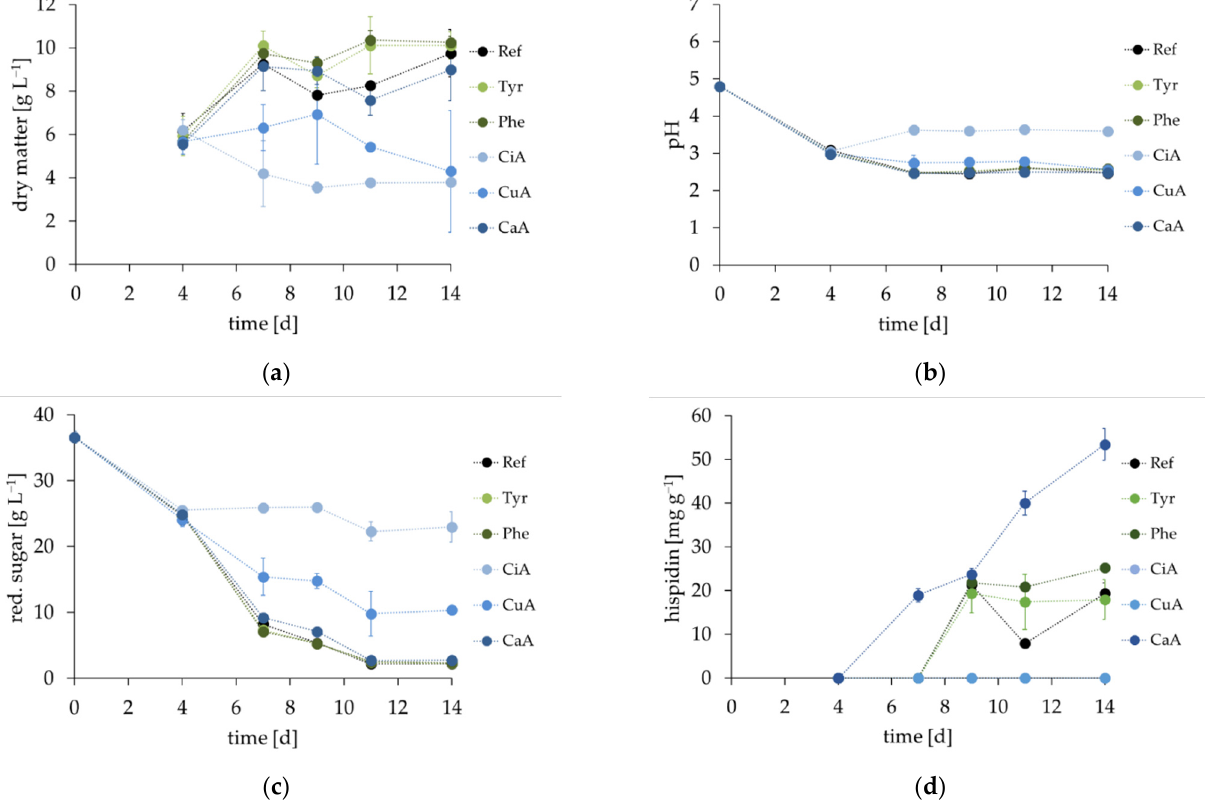
Figure 3. Cultivation of I. hispidus with precursors (2 mM supplemented on days 4, 7, 9, and 11). The control (Ref.) is depicted in black, L -tyrosine (Tyr) in light green, L -phenylalanine (Phe) in dark green, cinnamic acid (CiA) in light blue, p -coumaric acid (CuA) in blue, and caffeic acid (CaA) in dark blue. Comparison of ( a ) biomass yield, ( b ) pH value, ( c ) total content of reducing sugars, and ( d ) hispidin